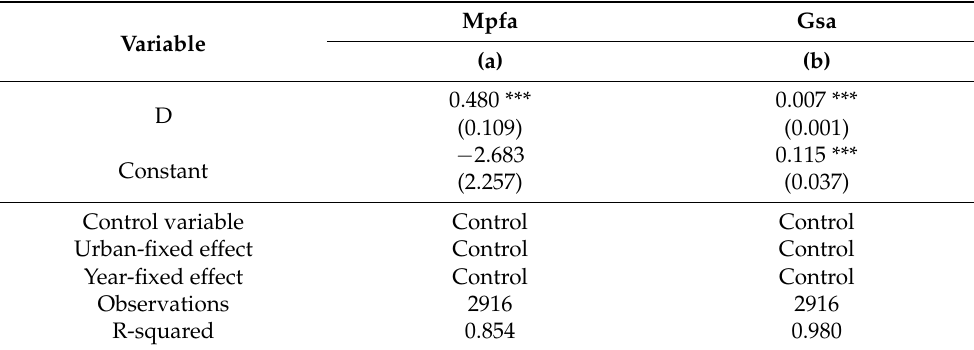
Table 4. Mechanism